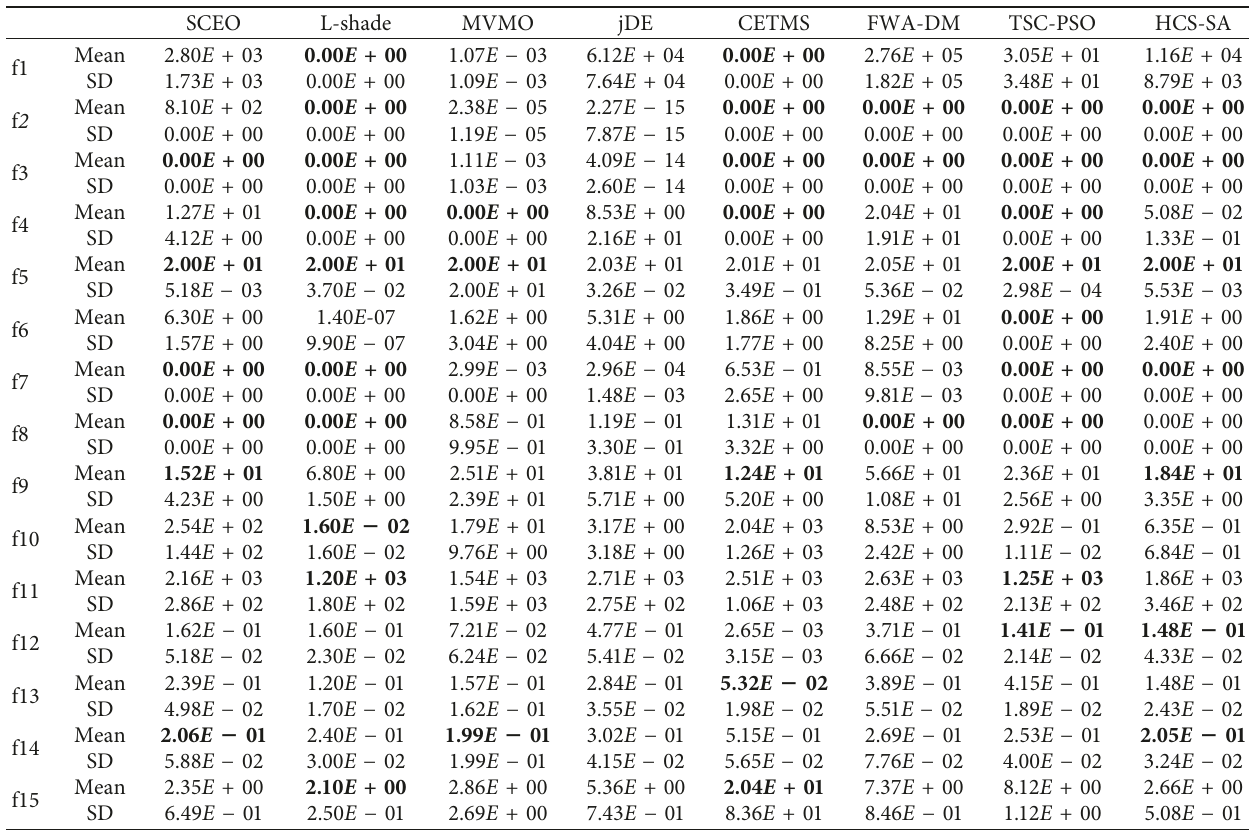
Table 15: Comparison with L-SHADE [36], MVMO [37], jDE [39], CETMS [40], FWA-DM [41], TSC-PSO [42], and HCA-SA [43] algorithms on CEC 2014 functions.